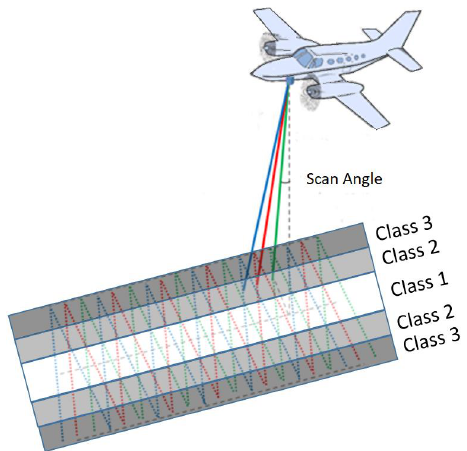
Figure 3. Configuration of scan angle classes from nadir (Class 1) to swath end (Class 3).